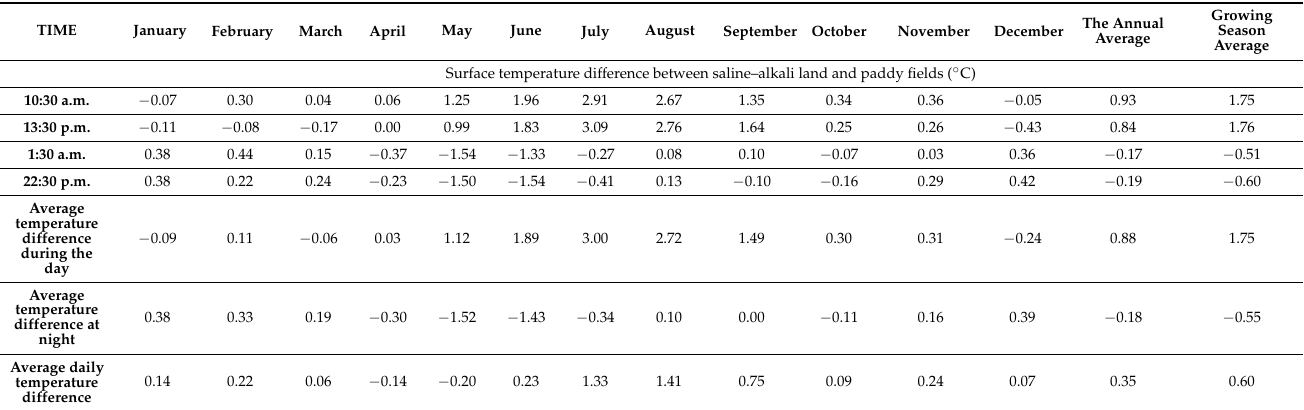
Figure 6. Diurnal variation of monthly mean surface temperature ( ◦ C) for saline–alkali land and paddy fields in Da’an City, western Jilin Province from 2015 to 2021. Table 3. Day-and-night surface temperature difference ( ◦ C) between saline–alkali land and paddy fields in the growing